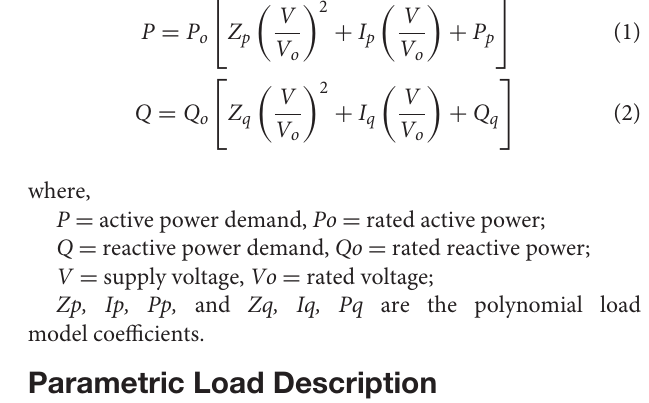
contemporary Watt-hour meter and an up-frequency converter